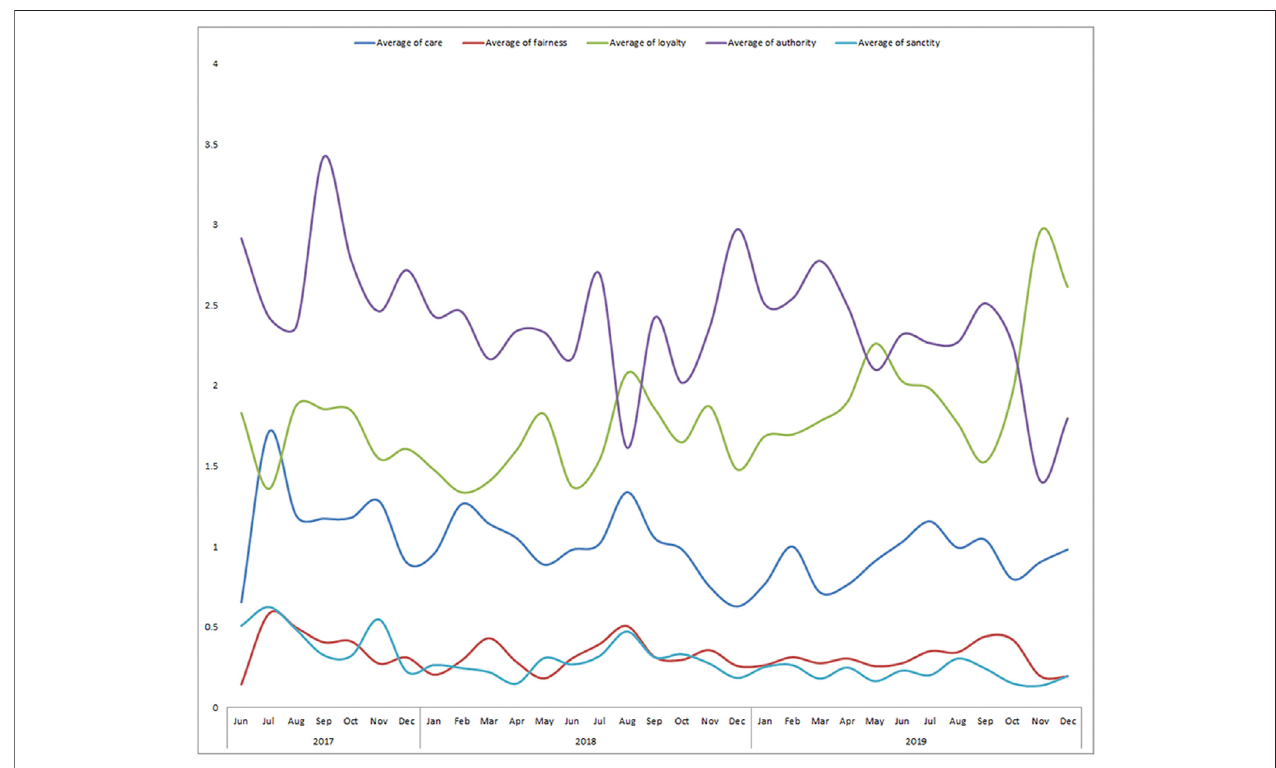
FIGURE3| LinegraphshowingtheaveragemoralintensityofBrexittweetsovertime.Thefoundationsofauthorityandloyaltyweremoststronglyused.Thisshows that moral arguments overall are sustained over time.